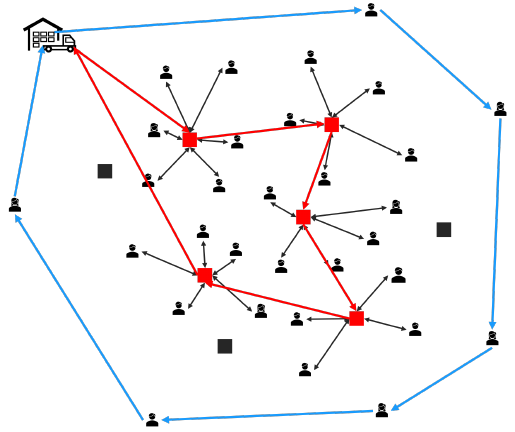
Figure 1. An example of solution of the present location-routing